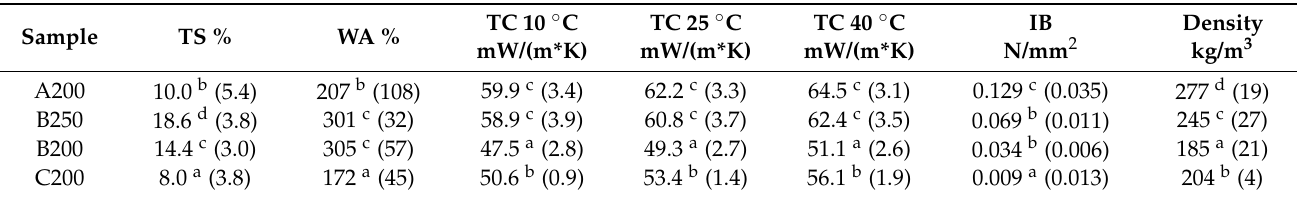
Table 2. Physical and mechanical properties of the spruce bark fibre insulation boards (values with the same letter (a, b, c, d, e) are not significantly different ANOVA, post-hoc Tukey HSD, p = 0.05; standard deviation in parentheses). Sample